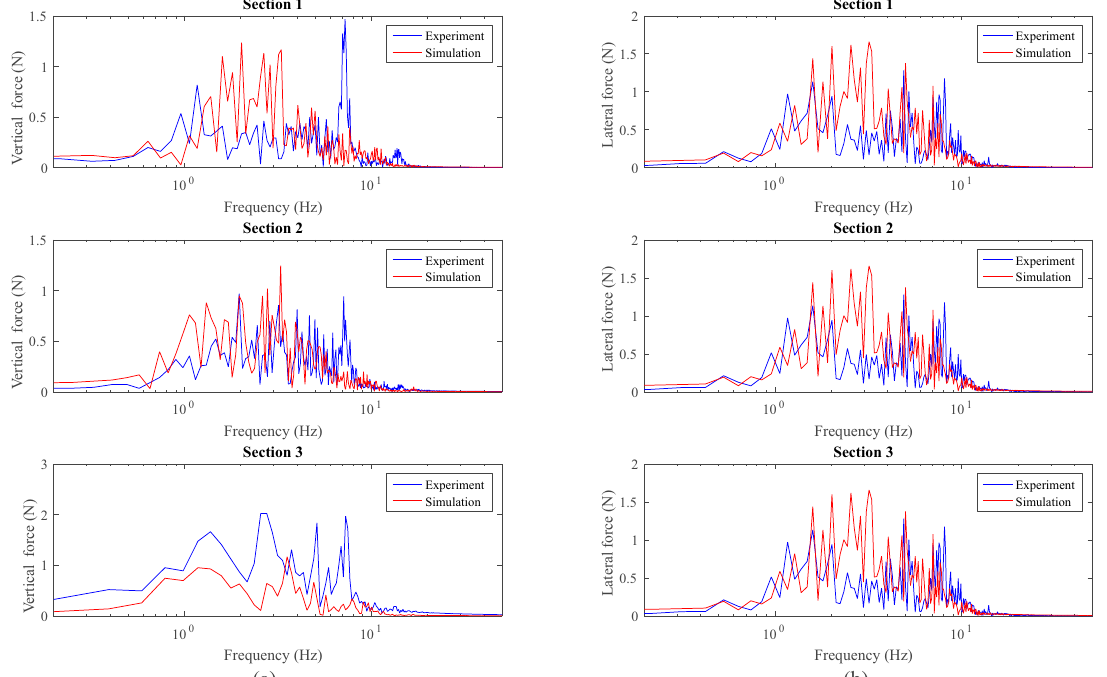
Figure 22. Frequency analysis of the applied vertical ( a ) and lateral ( b )